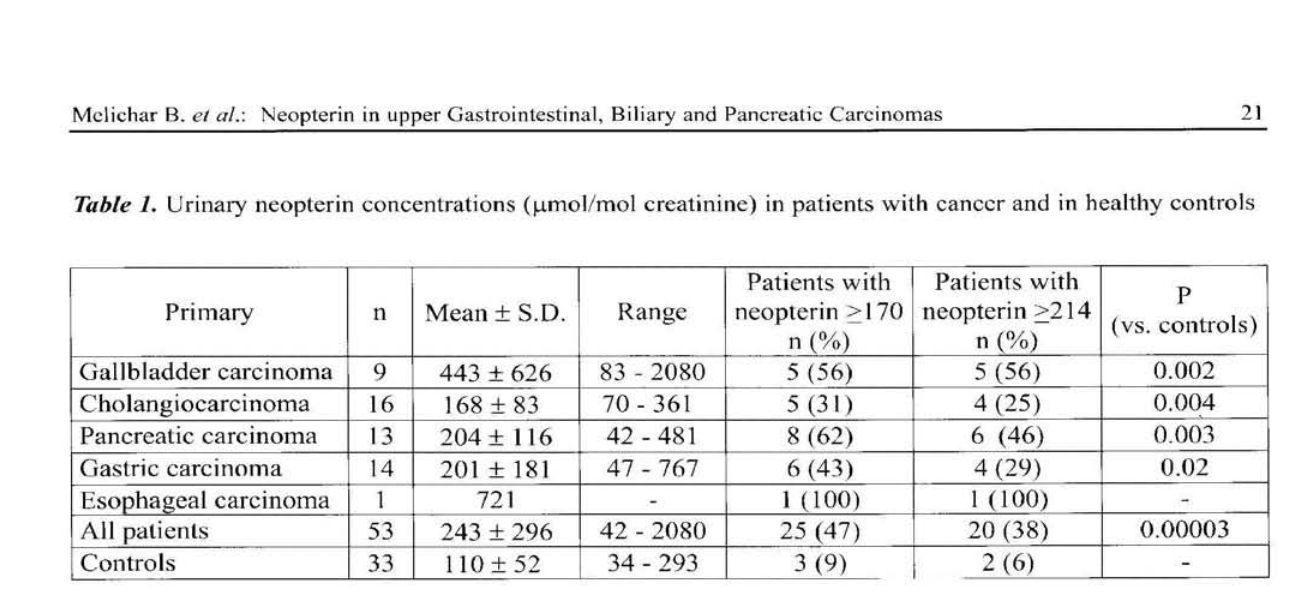
Table 1. Urinary neopterin concentrations (|j.mol/mol Creatinine) in patients with canccr and in healthy controls Primary n Mean ± S.D. Range